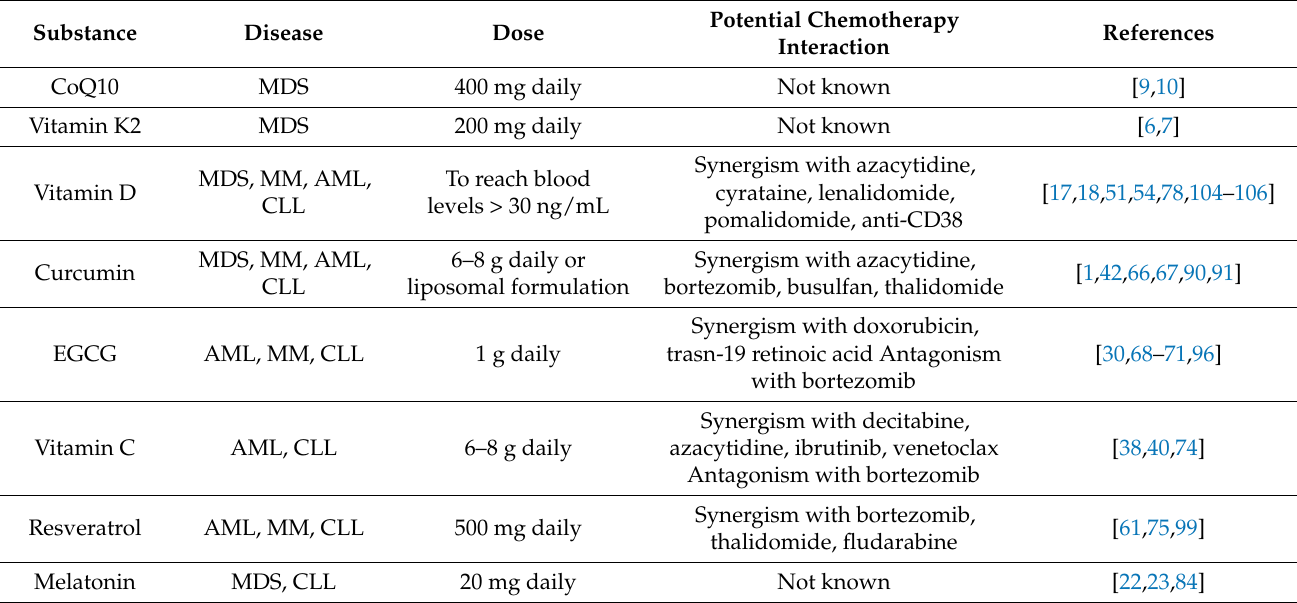
Table 1. Potential use of supplements or natural compounds in